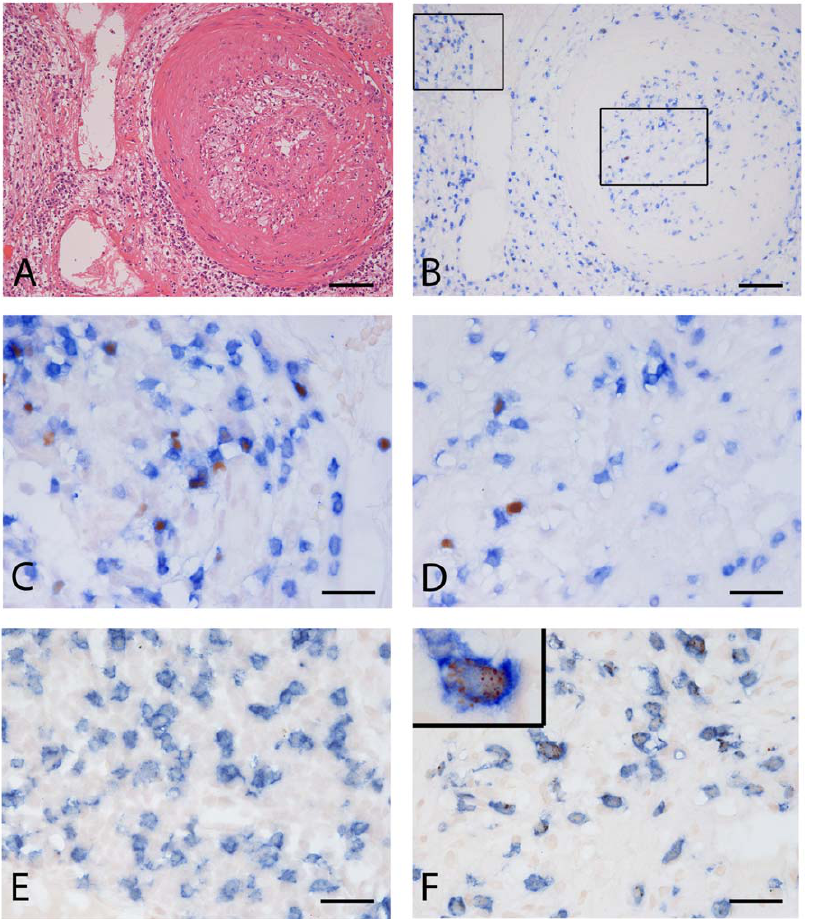
Figure 1. Histological examples of regulatory- and cytotoxic T cells in a nephrectomy specimen with allograft vasculopathy. All pictures are from the same specimen. A: H&E, overview. Bar=100 m m. B: Same area as in A, doublestained with FOXP3 (red) and CD3 (blue). Bar=100 m m. C: Detail from B, extra vascular area. Bar=25 m m. Note the nuclear staining of FOXP3. D. Detail of B, intravascular area (intima). Bar=25 m m. E: extra-vascular area (same region as in C), CD8 (blue)/Granzyme B(red) double staining. Bar=25 m m. F: intima (same region as D), CD8 (blue)/Granzyme B(red) double staining,. Bar=25 m m. Inset shows high power magnification, showing intracellular GranzymeB + granules (red).